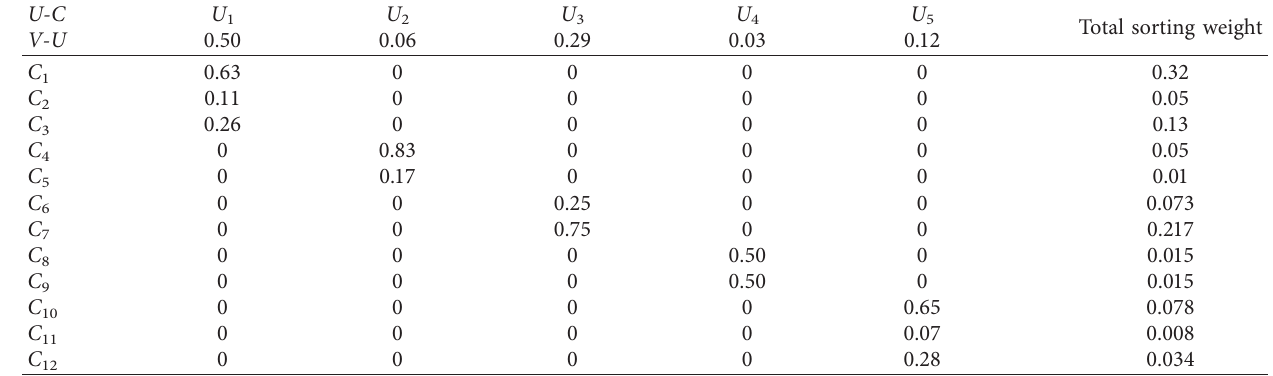
Table 10: Hierarchical total sorting